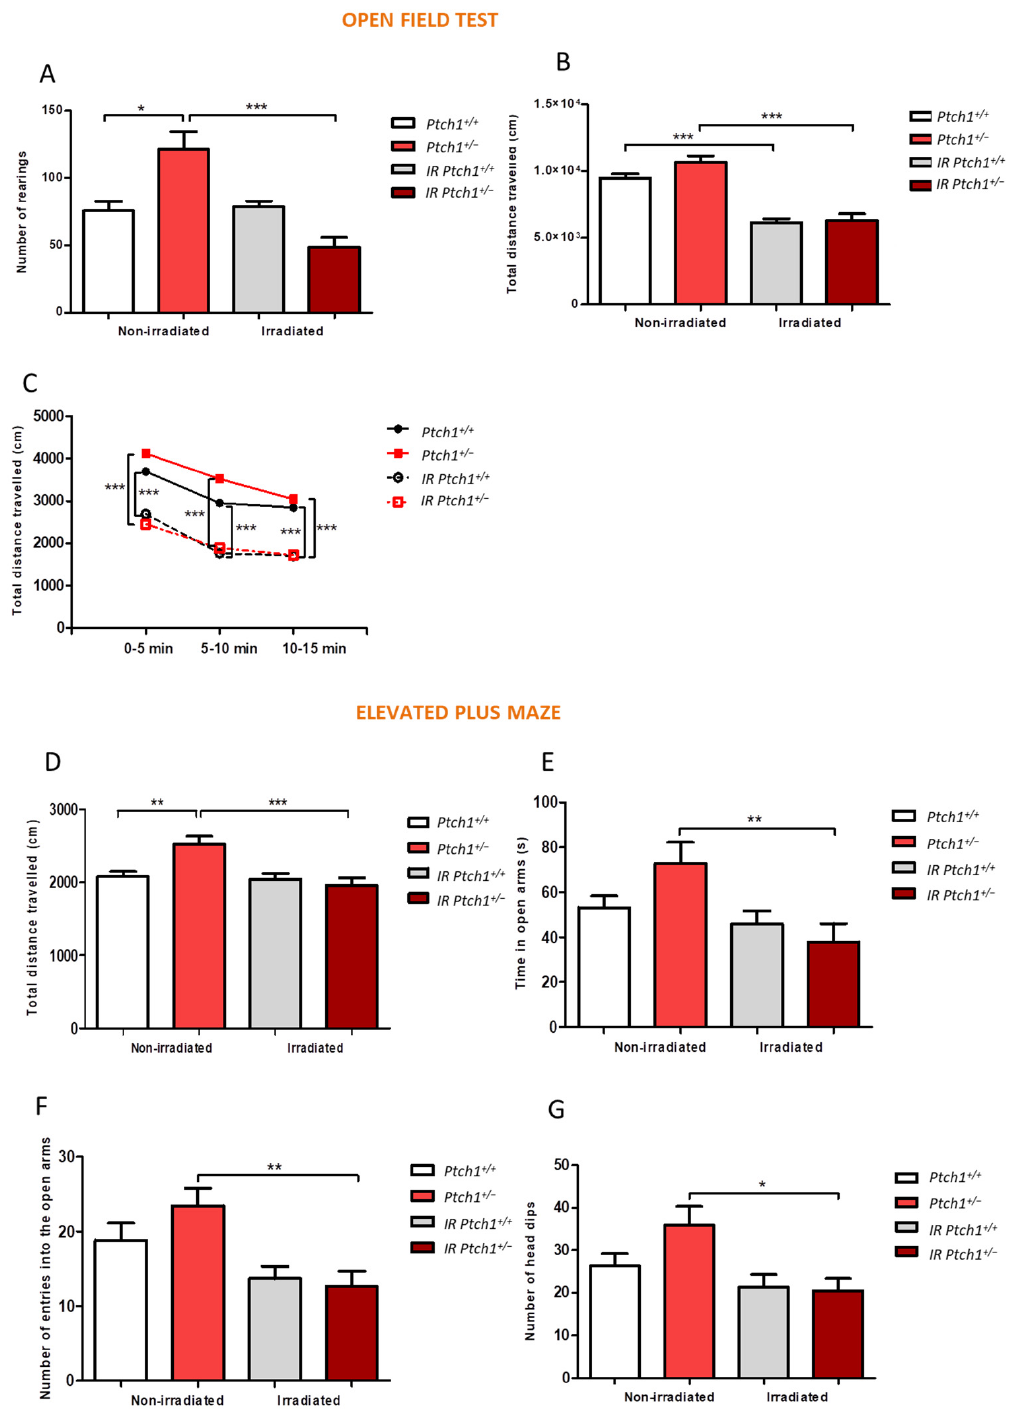
Figure 4. Long-term behavioral effect of irradiation with 5 Gy of X-rays at P10 in WT and Ptch1 +/ − mice at 8 months post-irradiation assessed through Open Field (OF) and Elevated Plus-Maze (EPM) tests. WT ( n = 18) and Ptch1 +/ − ( n = 15) mice irradiated or left unirradiated ( n = 17 for WT; n = 12 for Ptch1 +/ − ) were submitted to the tests. ( A ) Number of rearings in OF; ( B ) Total distance travelled in OF; ( C ) Total distance travelled (habituation) in OF. ( D ) Total distance travelled in EPM; ( E ) Time in open arms in EPM; ( F ) Number of entries into the open arms in EPM; ( G ) Number of head dips in EPM. Data are given as the mean ± SEM. * p < 0.05; ** p < 0.01; *** p < 0.001. Statistical significance for all tests (described in the “Cognitive Statistical Analysis” paragraph) was established at p < 0.05.